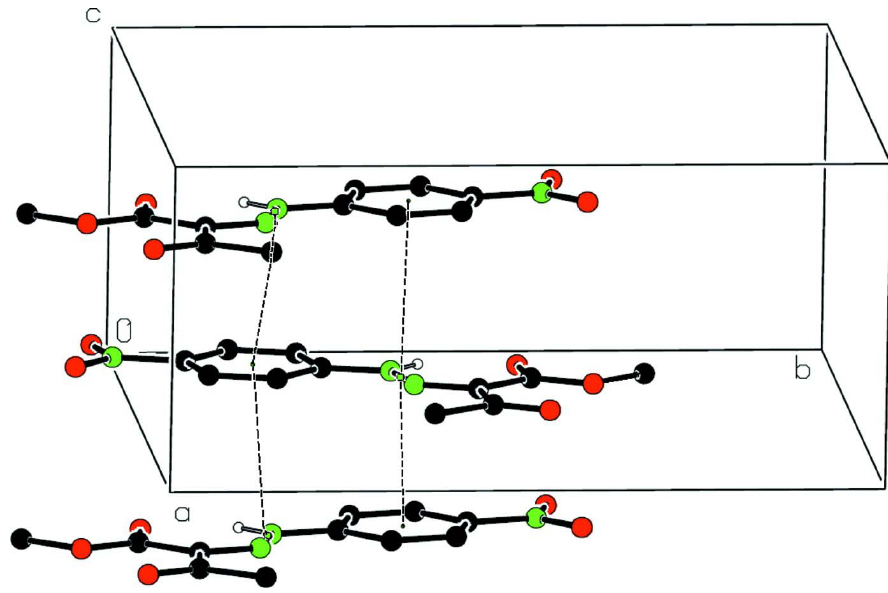
Figure 3 Excerpt of the crystal structure of the title compound, showing that along the c axis the N1—N2 bond center of one molecule combines its up and down phenyl rings in the other two molecules into a three dimensional framework. H atoms not involved in hydrogen bonding have been omitted.